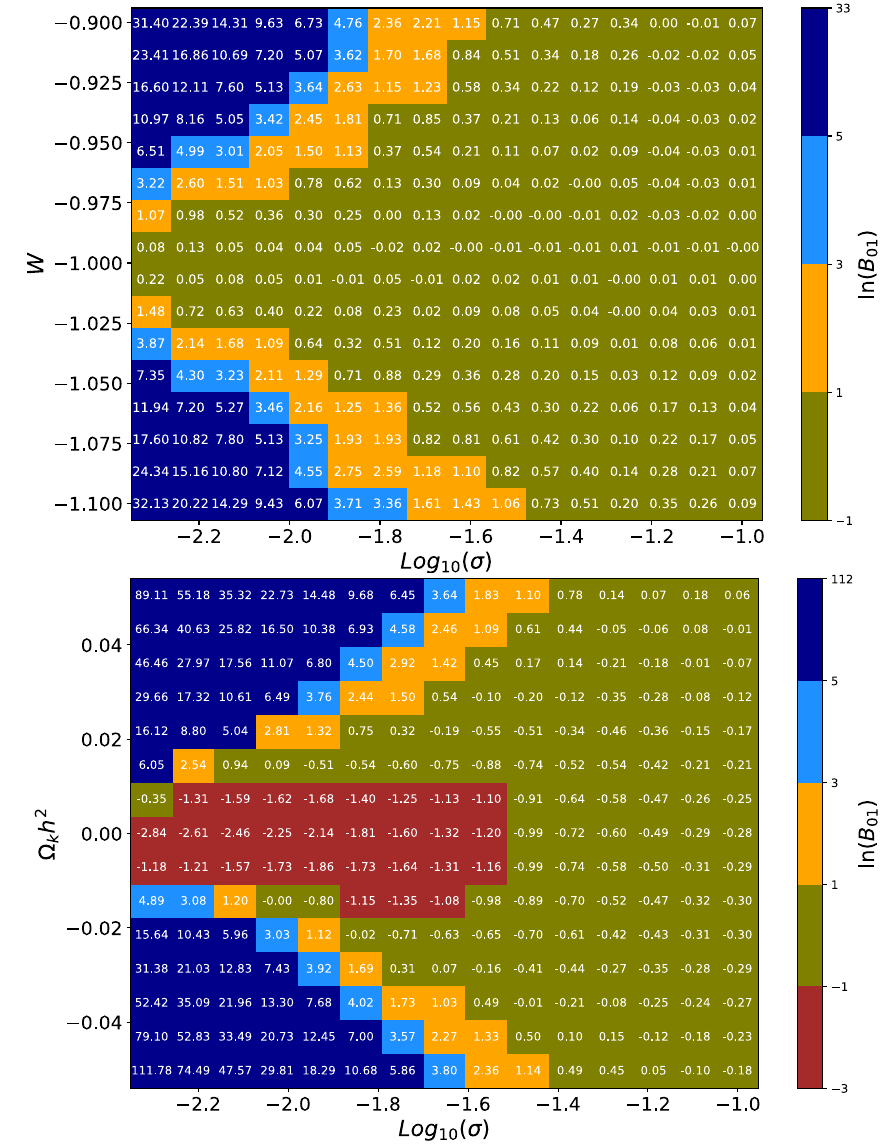
Fig. 2 The mean Bayes factor for the Λ CDM and wCDM using the second sampling strategy. Different colors show different criterion in Table 2